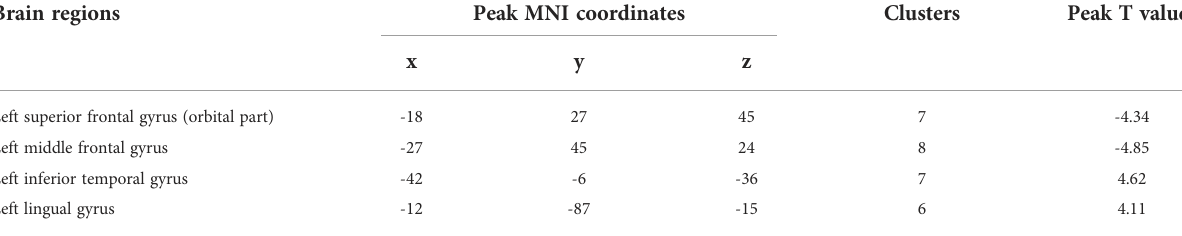
TABLE 5 Comparisons of ReHo values of brain regions in the AAL template between NSCLC patients received pemetrexed plus carboplatin chemotherapy and paclitaxel plus carboplatin chemotherapy. Brain regions